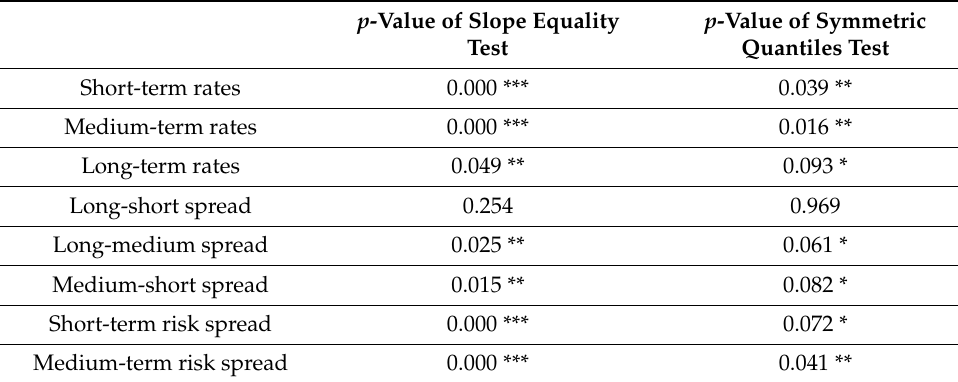
Table 2. Asymmetry test results.